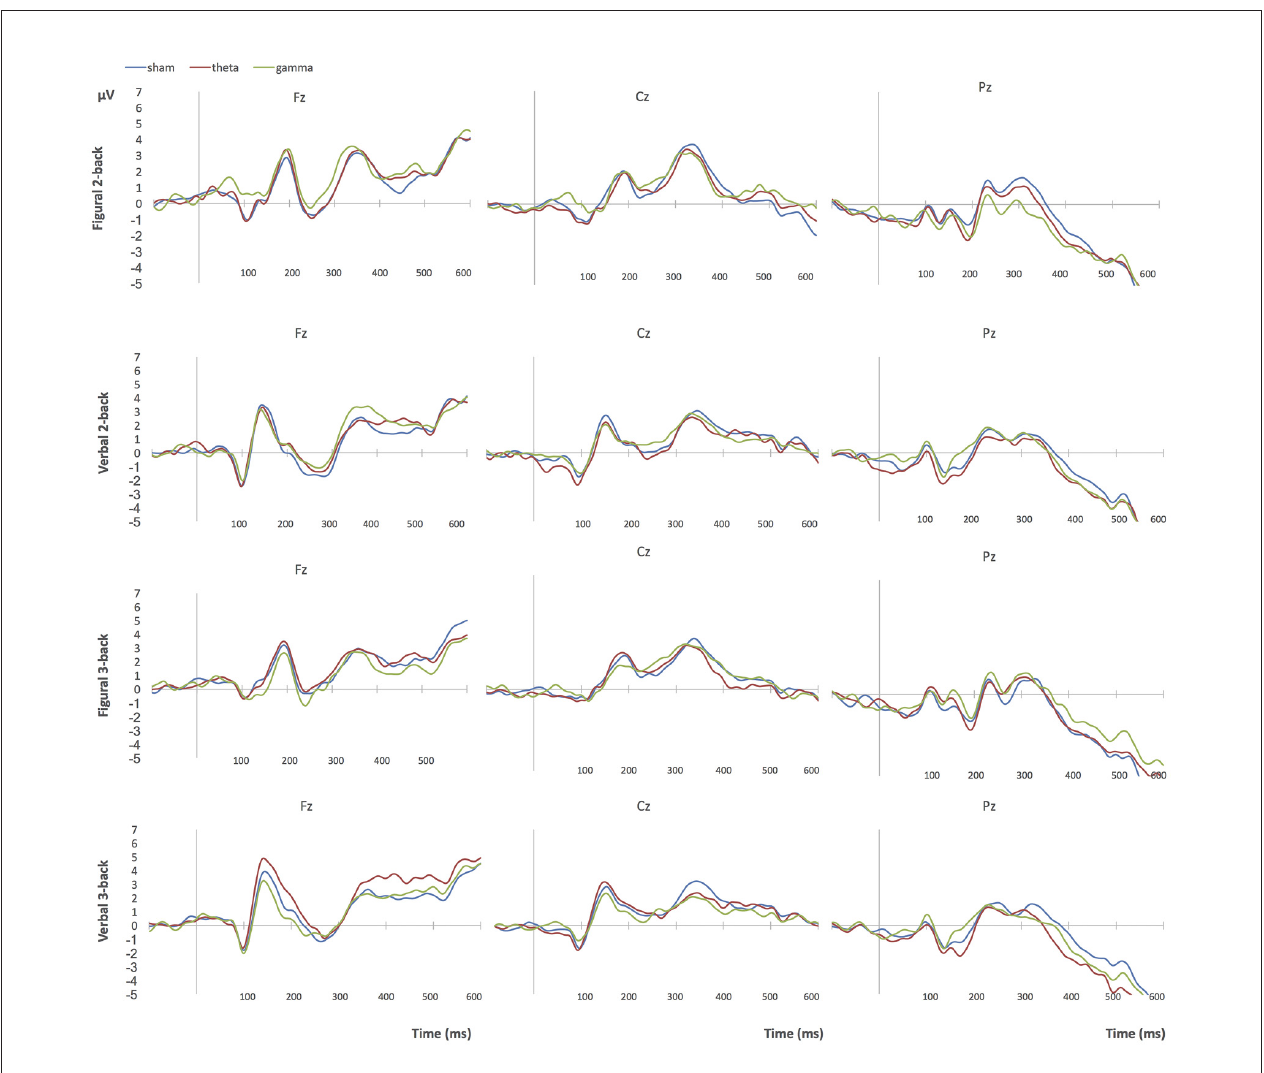
FIGURE 4 | Grand-average ERPs at midline electrodes during performance on n-back tasks in Group 1 (bilateral parietal stimulation). Blue = sham tACS session, red = theta tACS session, green = gamma tACS